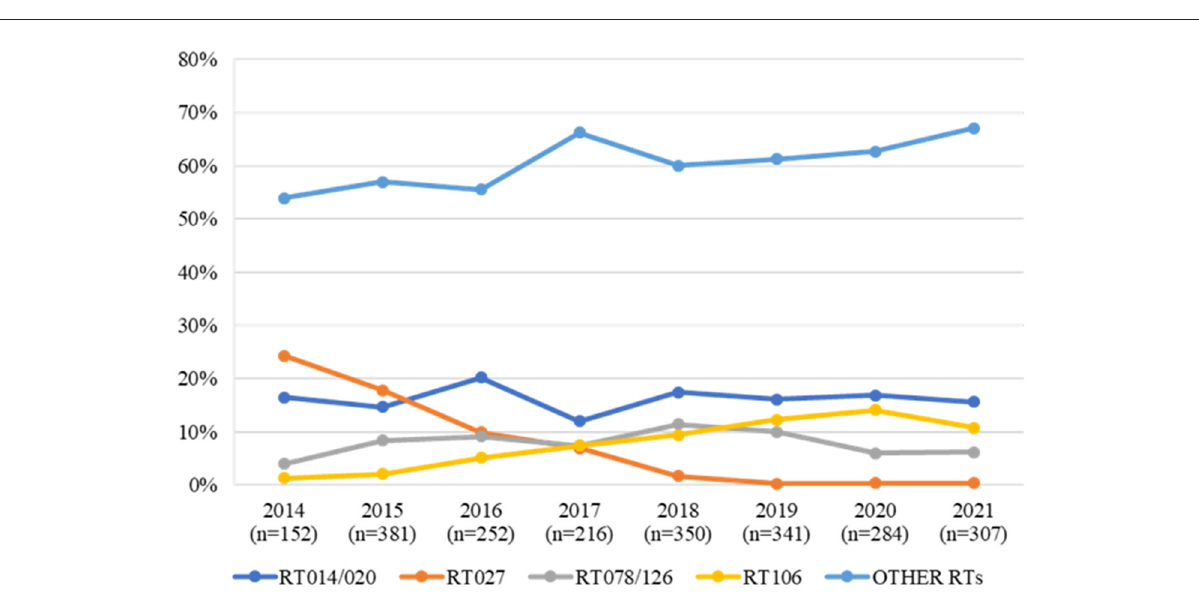
FIGURE2 Trend of RT014/020, RT027, RT078/126 and RT106 strains isolated from human clinical infections over an 8-year period (2014–2021) in Portugal. All other ribotypes are compiled in the “OTHER RTs”